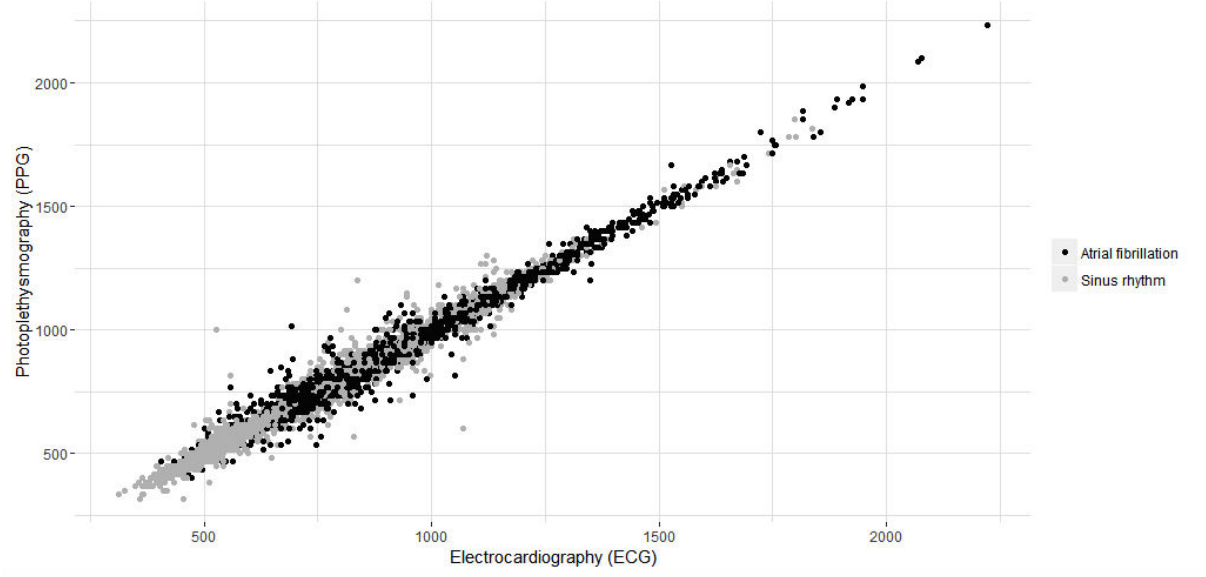
Figure 13. Correlation of intervals for both techniques (ie, electrocardiography [ECG] and photoplethysmography [PPG]) in milliseconds. Gray, irregular intervals; Black, regular